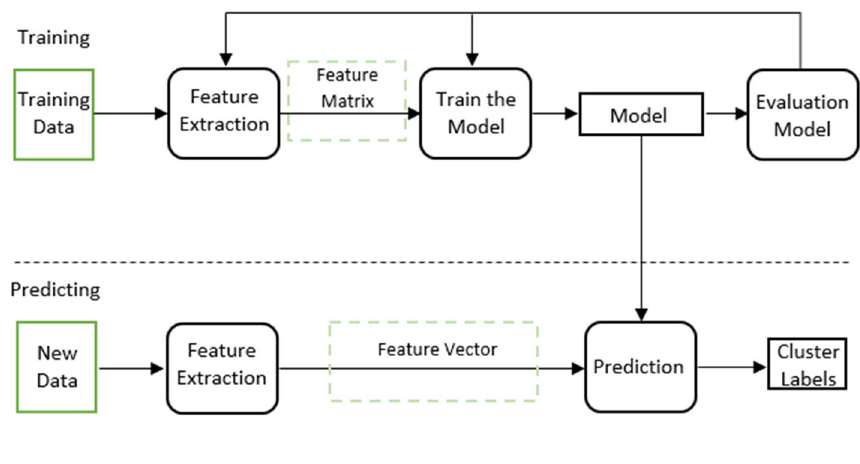
Fig. 2 Unsupervised learning